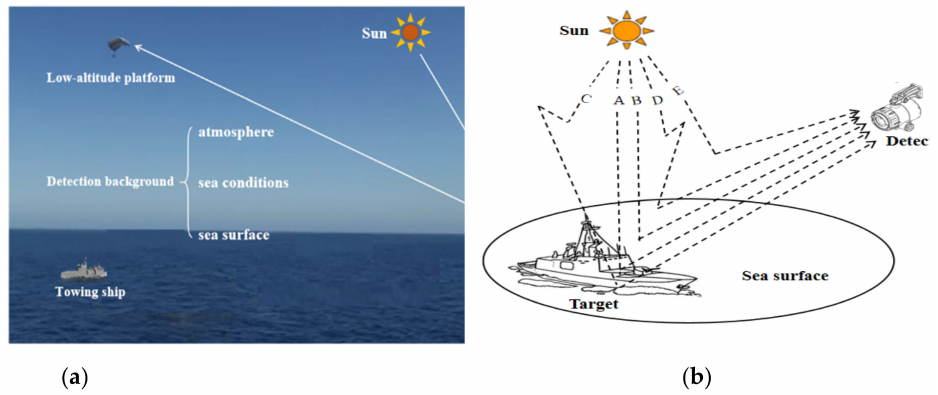
Figure 2. Low-altitude squint detection scene and radiation effect diagram. ( a ) Specific imaging detection scene. ( b ) Radiation mechanism of imaging simulation for low-altitude squint imaging detection application